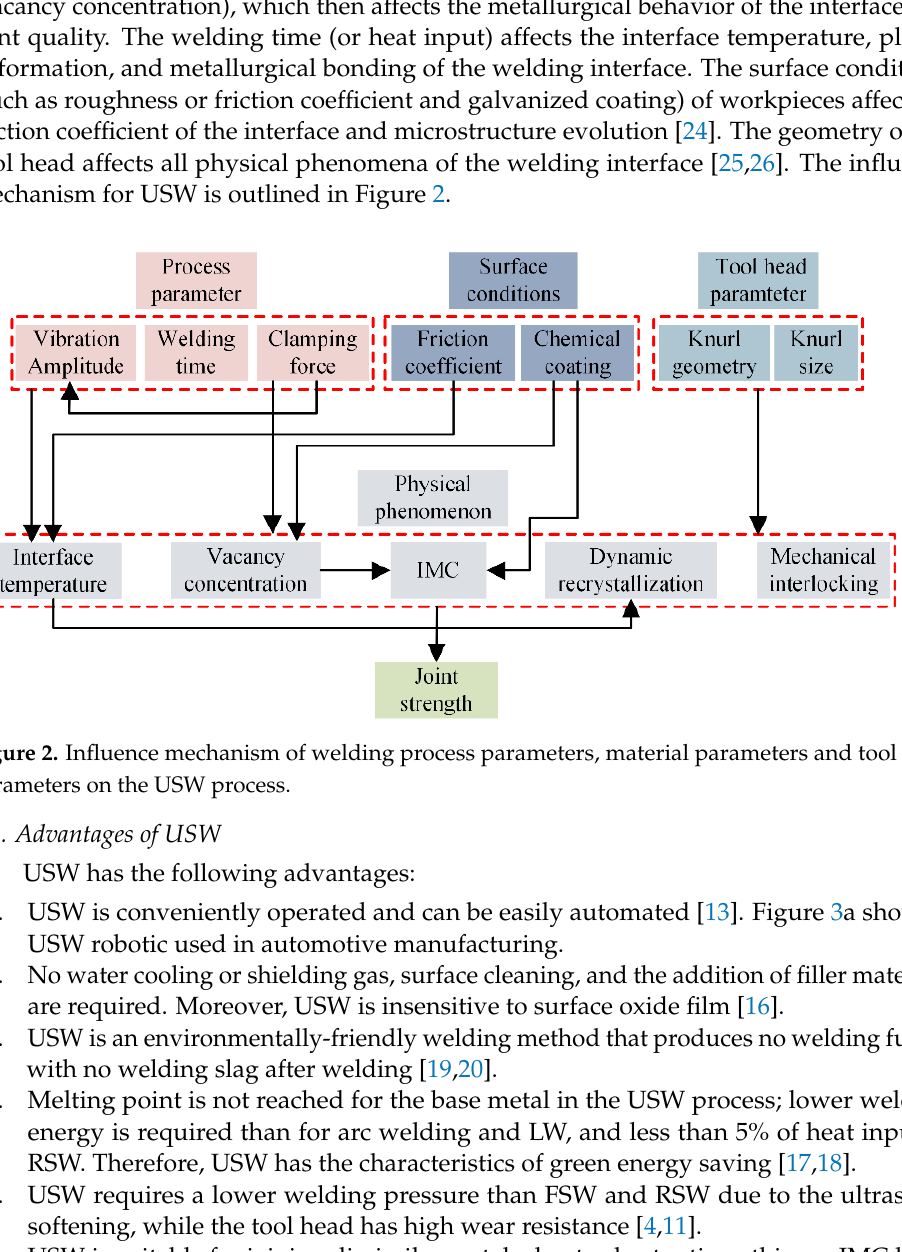
Figure 1. The principle of USW [23].